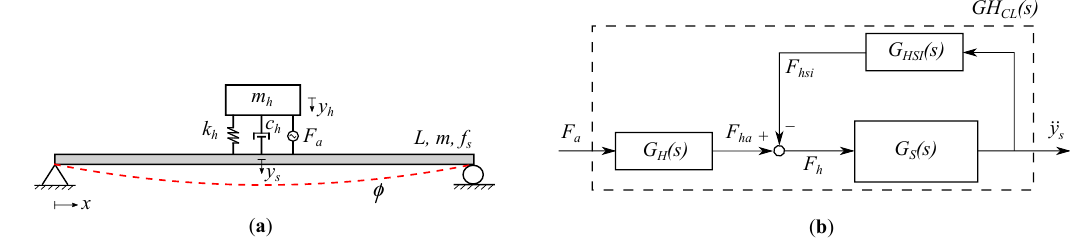
Figure 10. HSI model: ( a ) Schematic representation. ( b ) Block